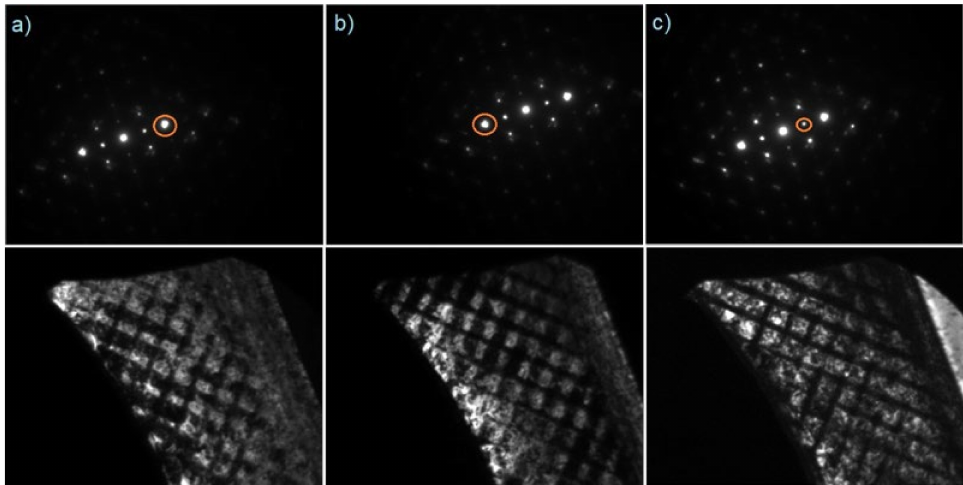
Figure 3. Selected area diffraction pattern (upper row) and corresponding dark field images (lower row) of the same checkerboard area. The diffraction spots used for the respective DF images are marked by the orange